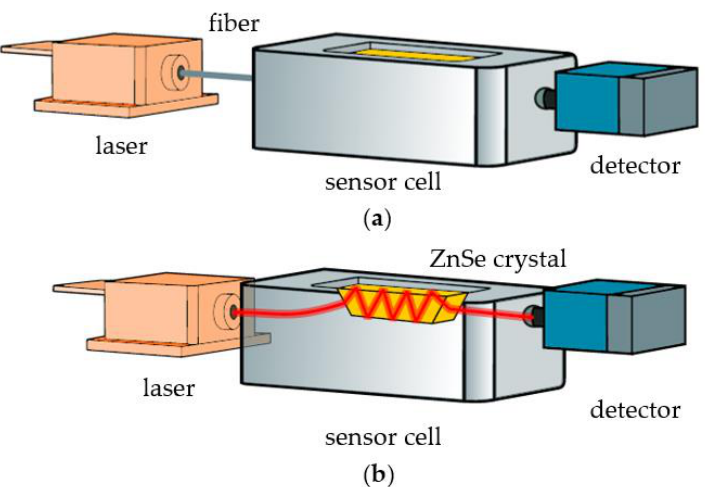
Figure 2. Schematics of the used analytical setups. ( a ) The QCL is coupled via a hollow-core fiber to the RobustATR assembly with the detector directly coupled to the distal end; ( b ) the QCL is also directly coupled to the RobustATR assembly. It should be noted that the iHWG in- and outcoupling structures integrated into the RobustATR assembly are not shown, for clarity, and that the laser beam path is therefore only schematically indicated. This light propagation does not show the real path. (Elements in the Figure not to scale).